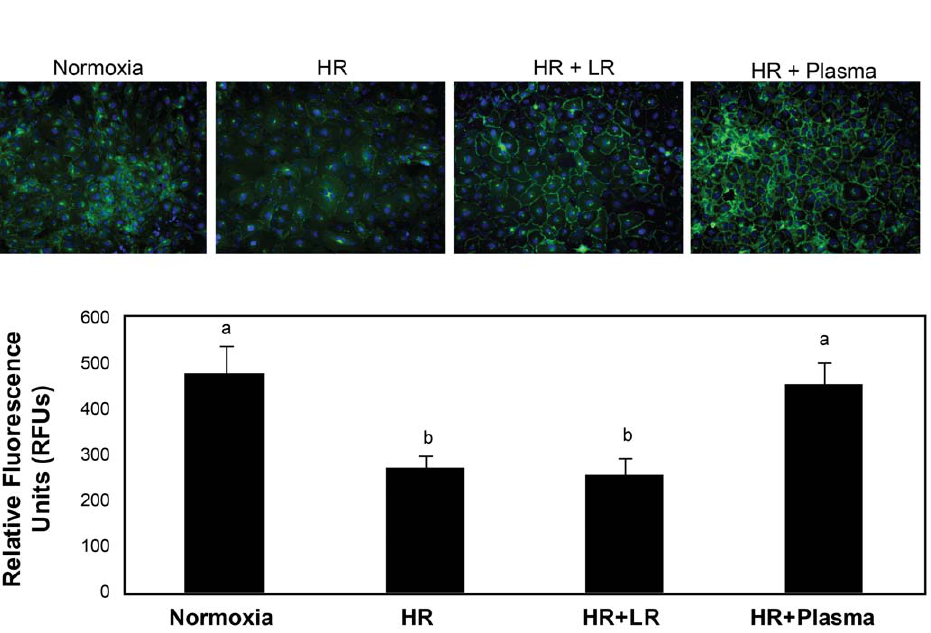
Figure 4. VE-cadherin immunoreactivity is enhanced by FFP in an in vitro model of endothelial injury. HUVEC’s were stimulated with IL- 1 b and subjected to hypoxia for four hours followed by rexoygenation and incubation for an additional four hours in media alone (hypoxia/ reoxygenation, HR), 5% lactated Ringers (LR), or 5% FFP, and compared to normoxia. A. Cells were labeled with antibody to VE-cadherin and images captured with an IX71 inverted microscope. Original image magnification, 6 40. B. The relative fluorescence intensity was quantified using Image J software (NIH) and reported as relative fluorescence units (RFU). Results are presented as means 6 SEM, n=3/group. VE-cadherin immunoreactivity was reduced by HR and LR compared to normoxia, but enhanced by FFP.